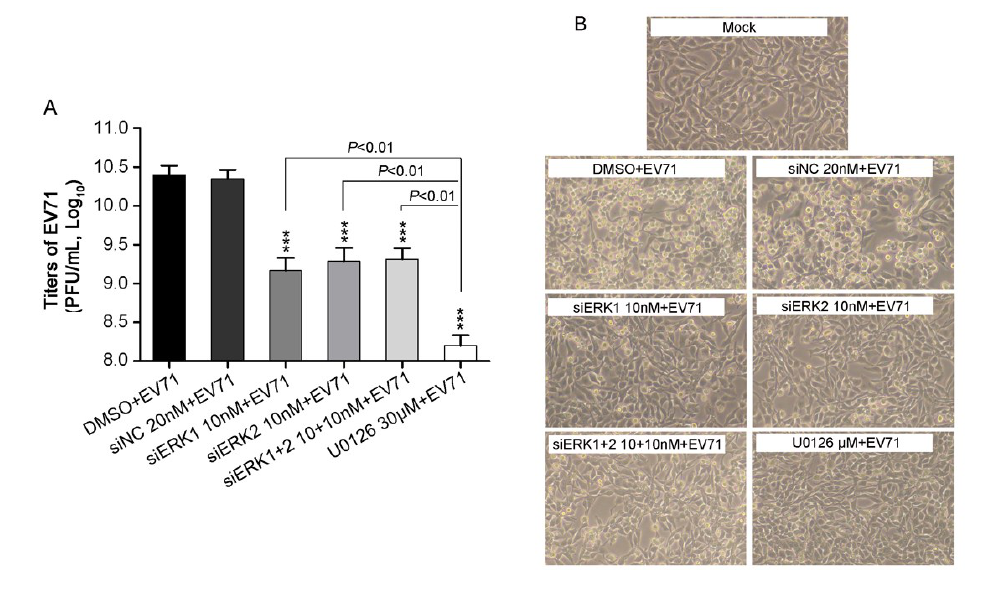
Figure 2. EV71 titers and CPE in RD cells treatment with distinct siERK (s) or U0126. ( A ) RD cells, pre-transfected with siERK1, siERK2 or siERK1+2 for 36 h, respectively, or treated with U0126 1 h prior to infection, were infected with EV71 at an MOI of 2. Cells pre-treated with DMSO or siNC were done as parallels. At 24 h p.i., both supernatants and cell lysates were collected and applied for determining the total titers of EV71 by titration; ( B ) Experiments were performed as described in panel A except CPE was examined every 8 h and images were taken at 24 h p.i.. Each result represents the average of three independent experiments and is shown as the means ± standard deviations (SD). *** p < 0.001, versus corresponding controls by Student’s t